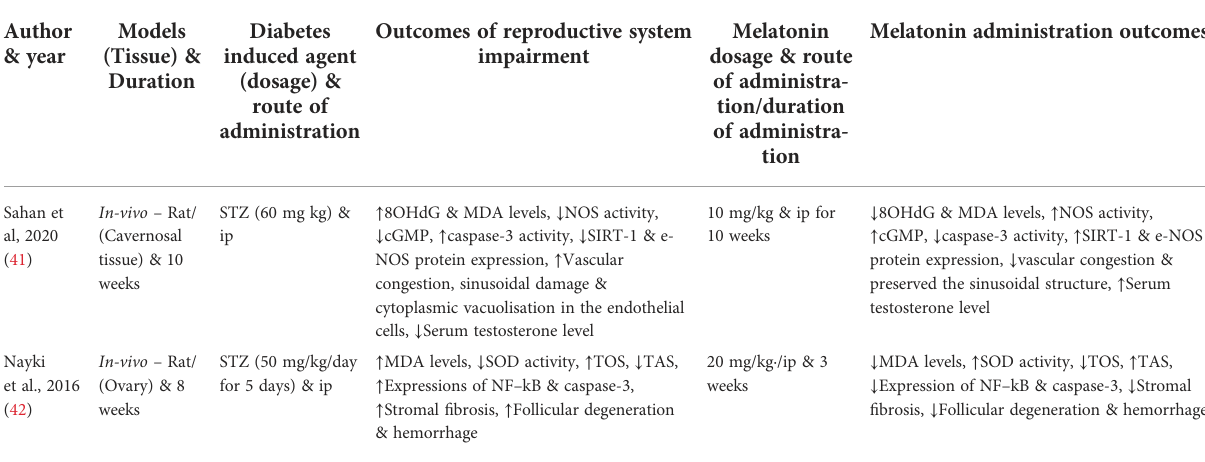
fi ndings represented stromal fi brosis, increased follicular degeneration, and hemorrhage normalized by melatonin co- treatment